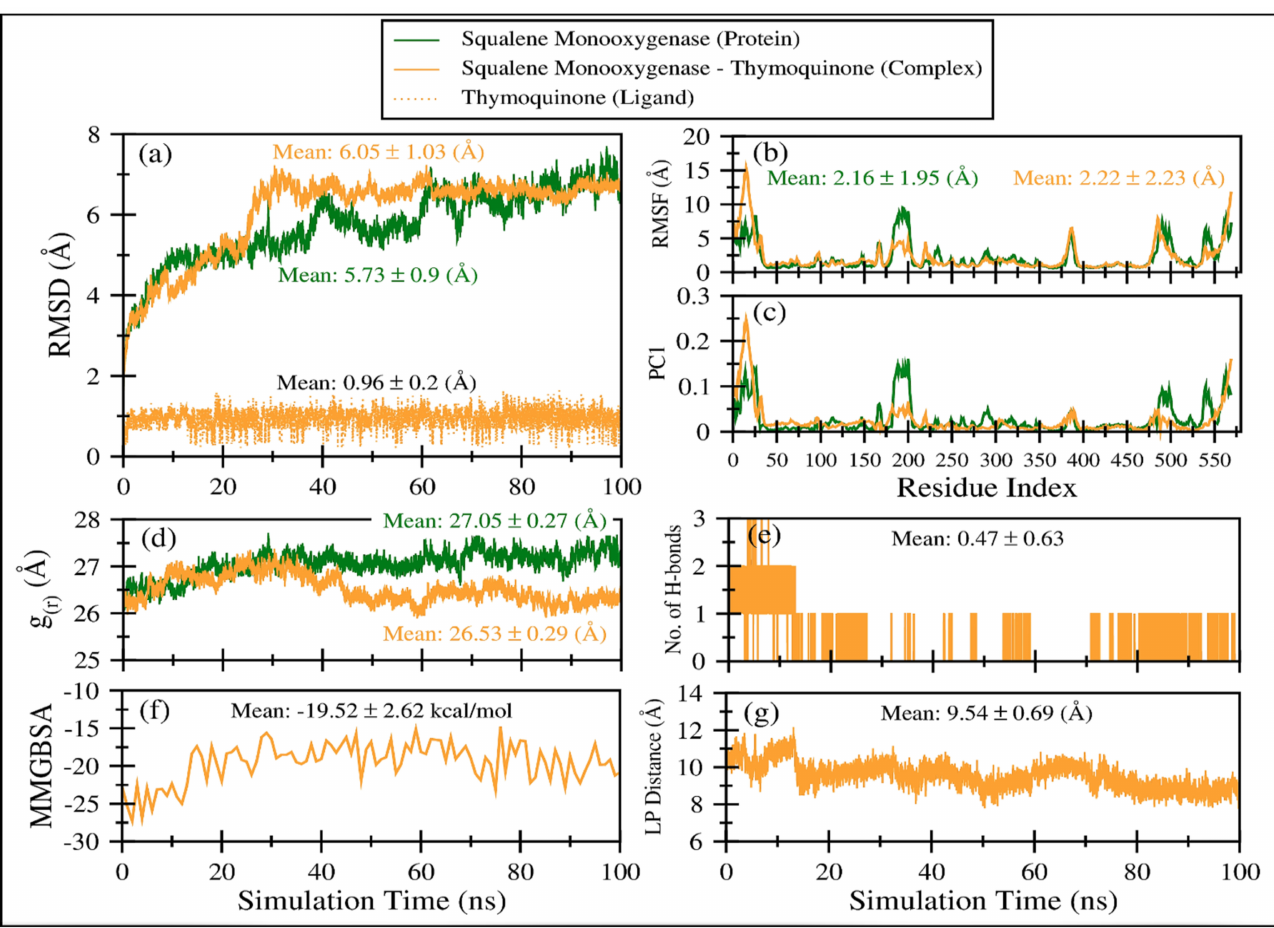
Figure 6. Various comparative analyses were performed on the trajectories of squalene monooxyge- nase in TQ-free (green line) and bound states (solid orange line). ( a ) Root mean square deviations using C α atoms of the protein. ( b ) Root mean square fluctuations using C α atoms of the protein. ( c ) Fluctuations as obtained from the principal analysis 1 using C α atoms of the protein. ( d ) Radius of gyration based on C α atoms of the protein. ( e ) Number of hydrogen bonds between TQ and squalene monooxygenase. ( f ) TQ and squalene monooxygenase binding energy as obtained from MMGBSA calculations. ( g ) Center-of-mass distance between TQ and squalene monooxygenase during the course of the MD